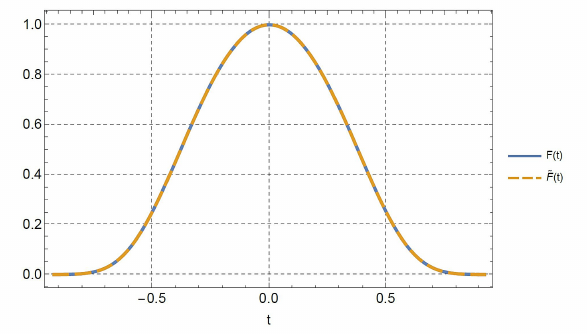
Figure 10. Graph of the function F ( t ) = exp [ − ( sinh ( 2 t )) 2 ] .